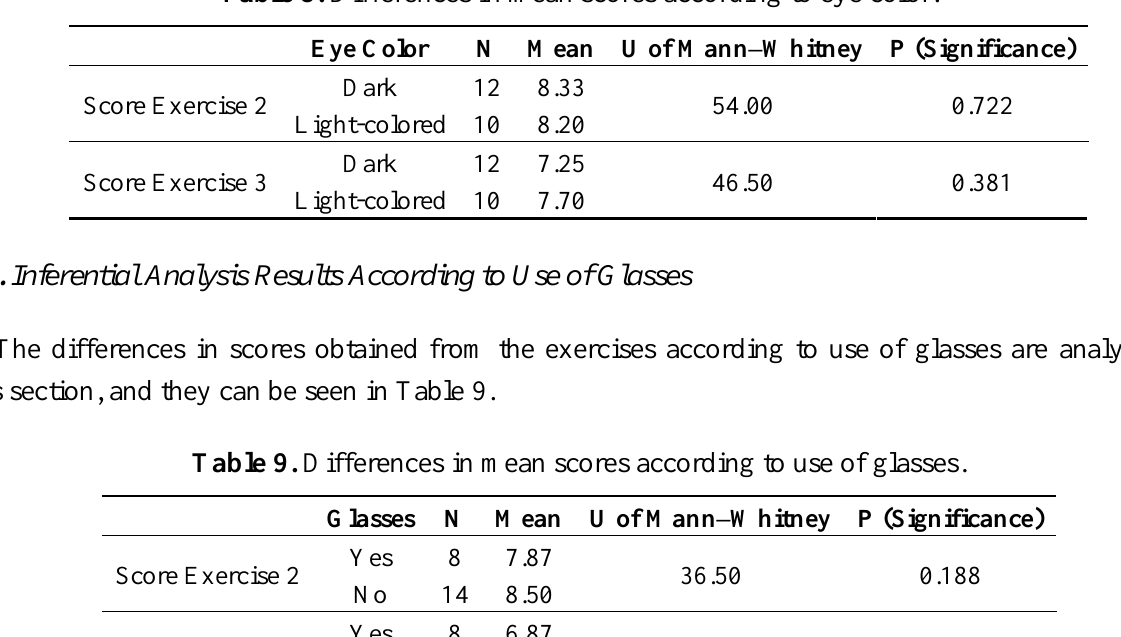
Table 8. Differences in mean scores according to eye color.